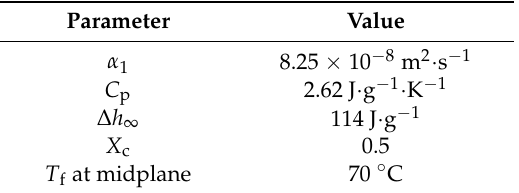
Table 2. Parameters adopted to calculate the temperature distribution along the sample thickness.